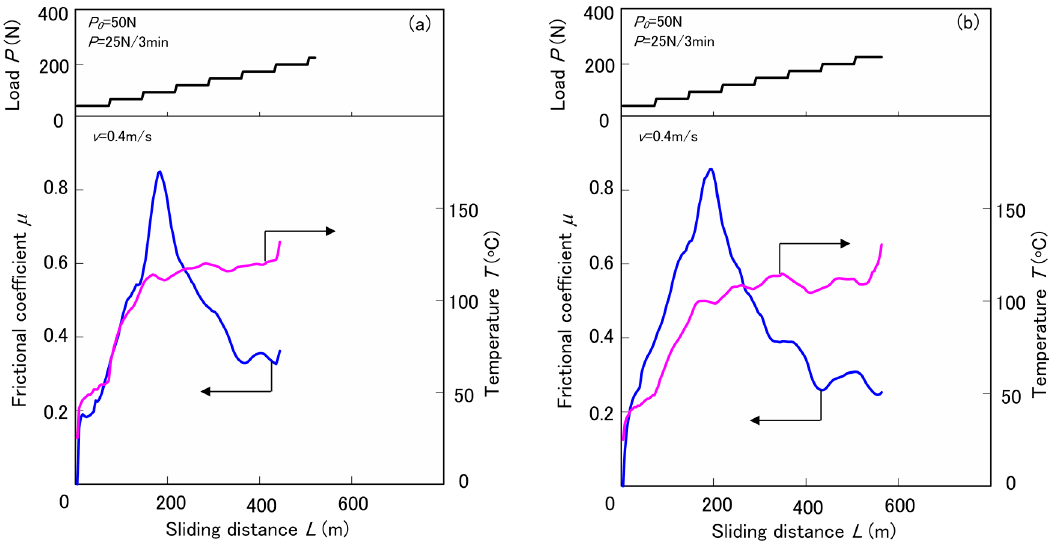
Figure 9. Frictional coefficient as a function of sliding distance measured by the step load test at v = 0.4 m/s for various surface-treated HF/PA1010 biomass composites: ( a ) HF and ( b ) HF-S3.